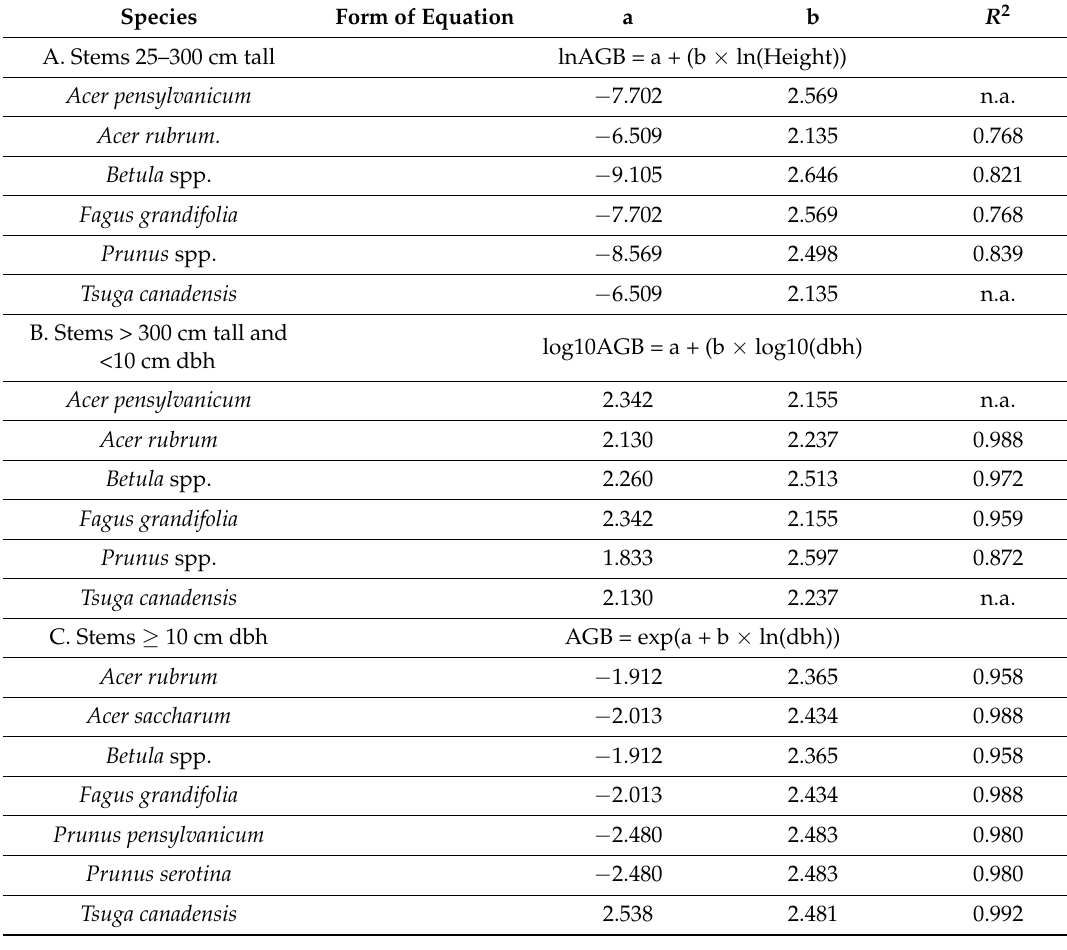
Table 1. Equations used to estimate the aboveground biomass (AGB) from plant height or trunk diameter at 1.4 m (dbh). Sources: A—A. Royo, unpublished data for Allegheny National Forest; B—Fatemi et al. (2011); C—Jenkins et al. (2003). Separate equations not available for Acer pensylvanicum or Tsuga canadensis in sizes categories, A or B; therefore, equations for Acer rubrum and Fagus grandifolia , respectively, were